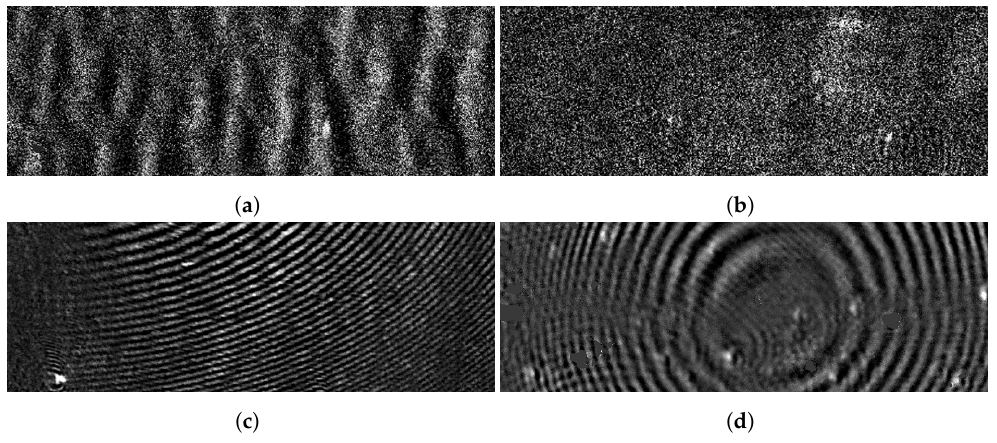
Figure 1. Example images extracted from different datasets recorded with the Plasmon-Assisted Microscopy of Nano-Objects (PAMONO) sensor after preprocessing and the application of dynamic contrast enhancement. Different dominating types of artifacts presented in Table 1 can be perceived. Random noise artifacts are present in each recorded image but vary in their intensities with differing environmental influences. ( a ) Washed out line artifact. ( b ) Dominant background noise with temporal brightness inconsistencies in an image region on the right. ( c ) Dominating higher frequency wave artifact with a center near the visible region. ( d ) Dominating lower frequency wave artifact with visible